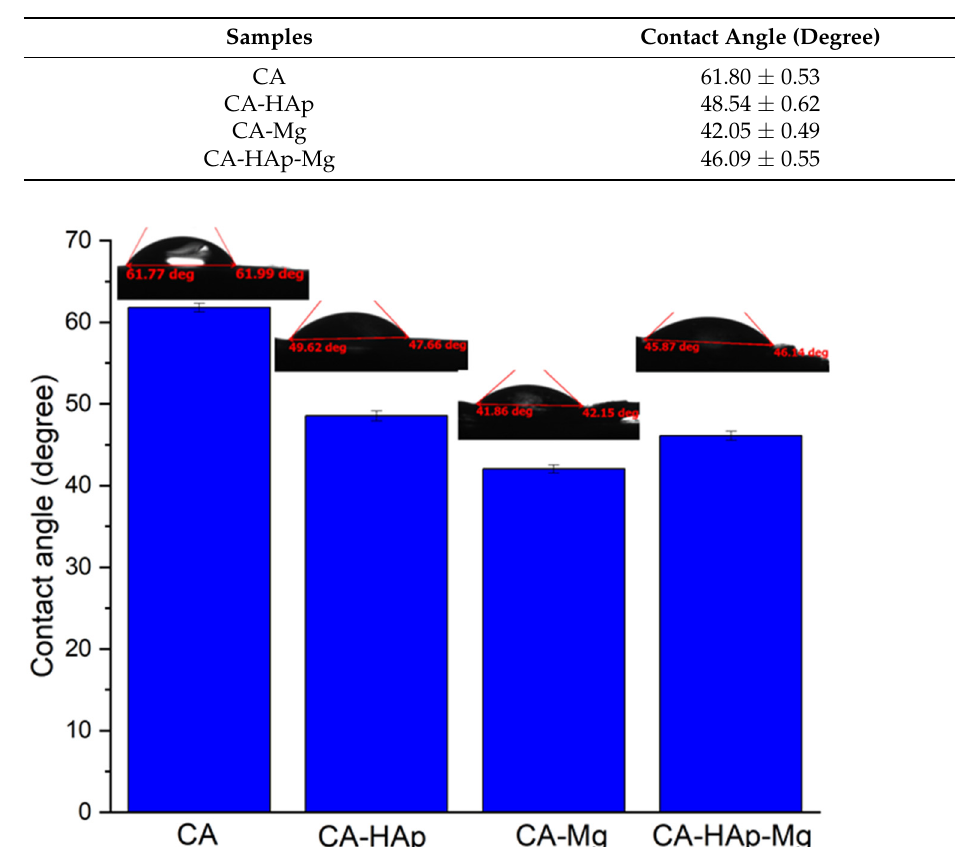
Table 4. Contact angle values.